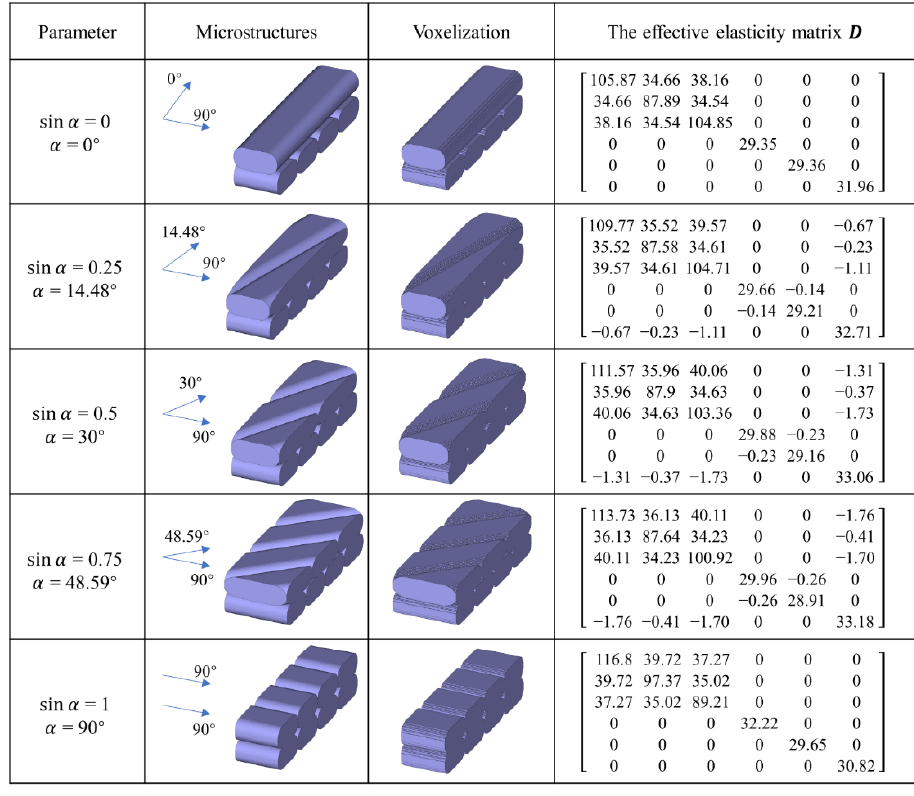
Figure 4. The representative periodic microstructures and their effective elasticity properties. Table 1. The fitting coefficients for the elastic constants.